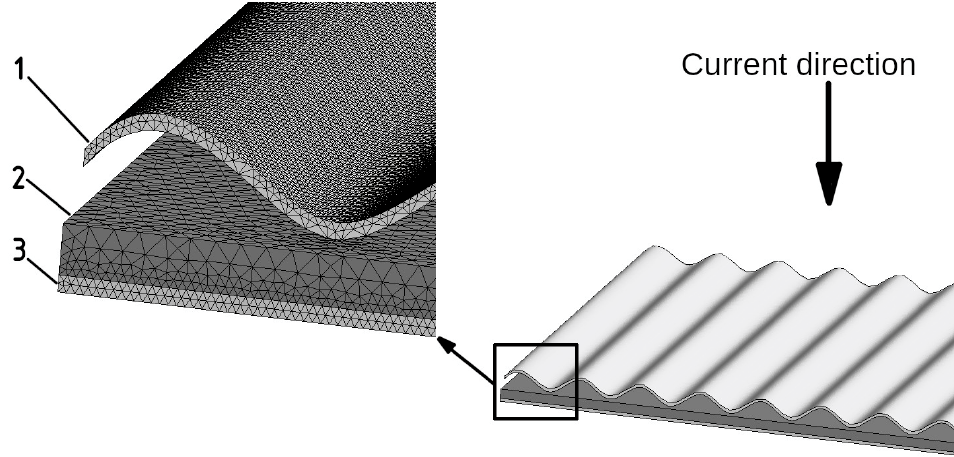
Figure 1. The geometric model of the fuel cell (1 and 3—electrodes, 2—membrane) and its finite element approximation.